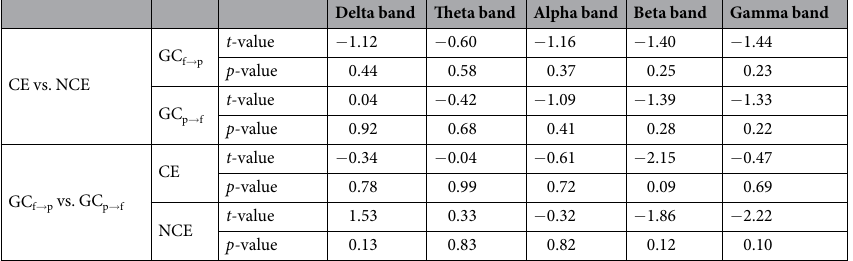
Table 3. Statistical values related to the directionality based on Granger causality. Note: N = 6; df = 5 for